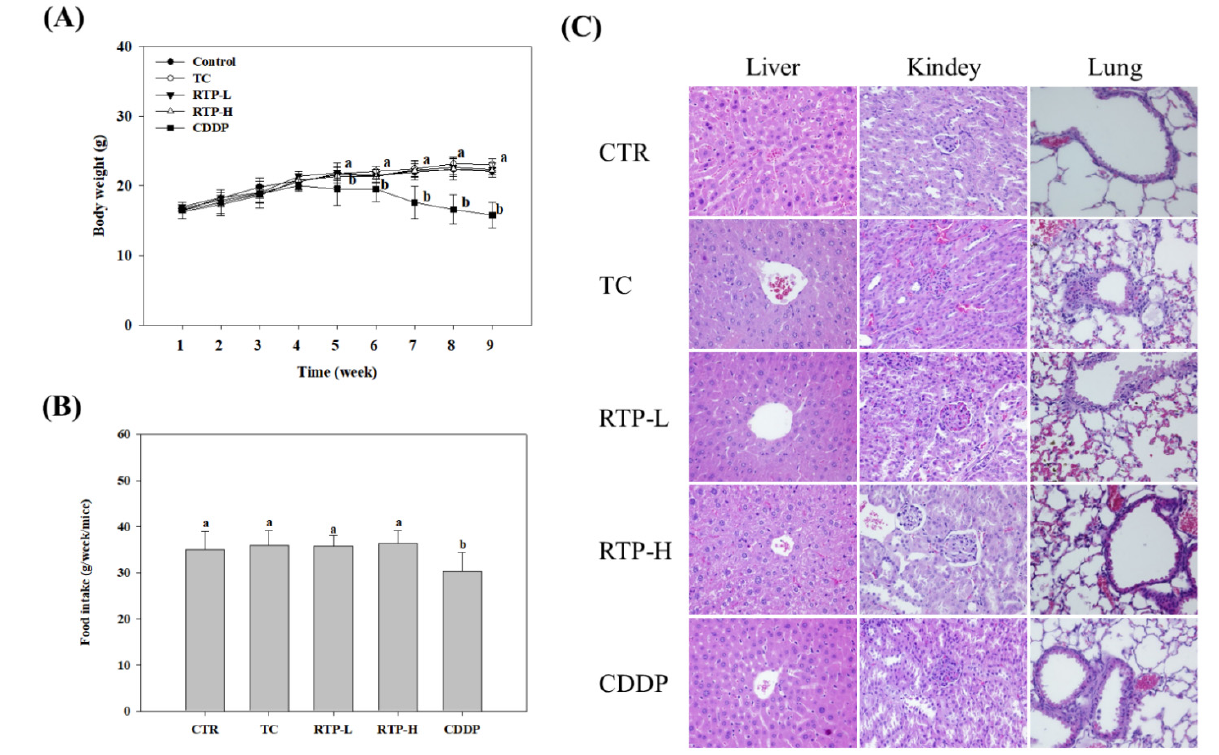
Figure 7. The ( A ) body weight, ( B ) food intake, and ( C ) hematoxylin and eosin staining of major organs in tumor-bearing mice. Male tumor-bearing nude mice were treated with rutaecarpine (RTP) or cisplatin (CDDP) as described in the Methods. The control (CTR) and tumor control (TC) were administered the vehicle only. Values (means ± SD, n = 9) not sharing a common lower case letter are significantly different ( p < 0.05). TC: tumor only; RTP-L: RTP by oral gavage at 25 mg/kg; RTP-H: RTP by oral gavage at 75 mg/kg; CDDP: intraperitoneally injected CDDP at 5 mg/kg. Table 1. Effects of rutaecarpine (RTP) on hematological parameters, blood urea nitrogen (BUN), and creatinine (Cre) of tumor-bearing mice 1 .